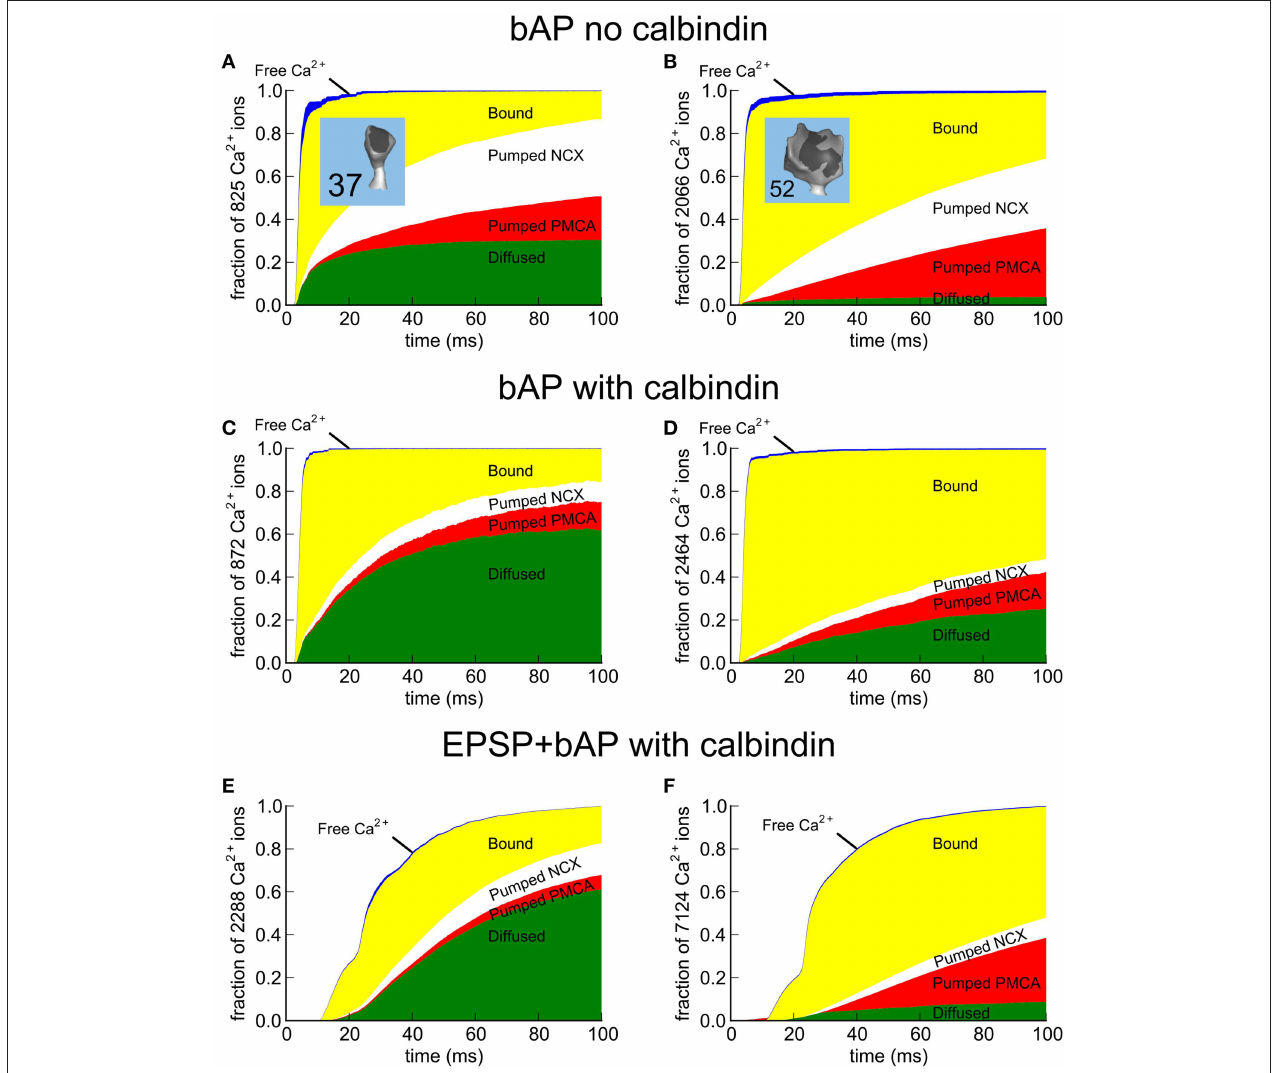
FIGURE 9 | Fate maps of Ca 2 + entering spines #37 and #52 in response to EPSP+bAP. The fate of all Ca 2 + entering the spines was tracked for 100ms after the stimulus. While inside the spine, Ca 2 + can diffuse freely (blue) or bind to Ca 2 + -binding proteins and pumps (yellow). To restore the resting state, Ca 2 + that enters is removed from the spine by PMCA pumps (red), NCX exchangers (white), or via diffusion through the spine neck (green) as free Ca 2 + or while bound to mobile calbindin. (A,C,E) FateofCa 2 + inmedian-sizespine#37; (A) afterabAPintheabsenceofcalbindin, (C) abAPinthepresenceofcalbindin,or (E) anEPSP+bAPinthepresenceof calbindin. (B,D,F) FateofCa 2 + inlargespine#52; (B) afterabAPintheabsenceofcalbindin, (D) abAPinthepresenceofcalbindin,or (F) anEPSP+bAPinthepresence of calbindin. Data is represented as a fraction of the total Ca 2 + influx. The actual number of Ca 2 + ions tracked is indicated in the y-axis